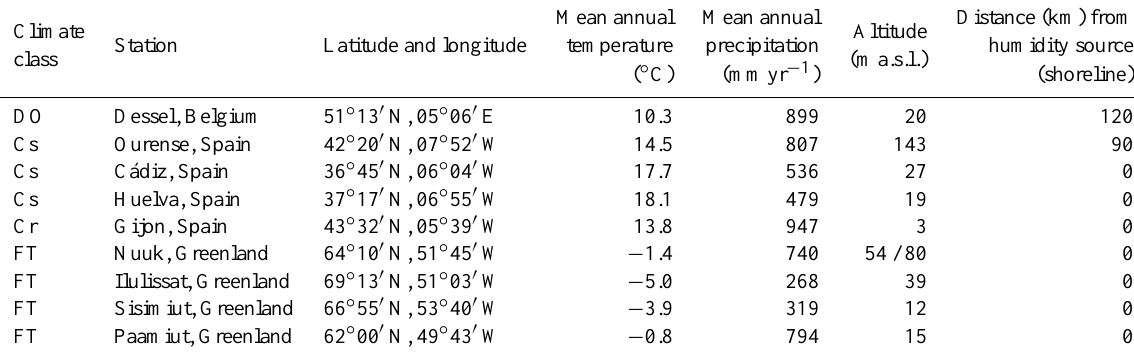
Table 1. Characteristics of selected analogue stations for different climate classes (DO=temperate oceanic, Cs/Cr=subtropical with/without rainfall seasonality, FT=tundra (with permafrost)). The Dessel site is the reference station for current climate. C´adiz is the station with the smallest rank deviation from Cs class average temperature (16.8 ◦ C) and precipitation (607mmyr − 1 ). Ourense and Huelva were selected as bounding cases for the precipitation. For the Cr class, sufficient input data were found only for Gijon. Sisimiut and Nuuk are the stations with the smallest rank deviations from FT class average temperature ( − 2.0 ◦ C) and precipitation (571mmyr − 1 ). Paamiut and Ilulissat were selected as bounding cases for the